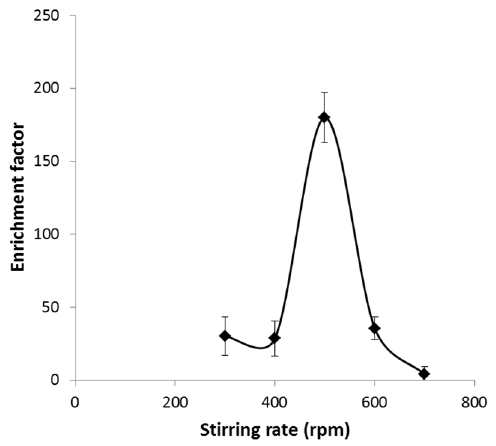
Figure 6. Effect of stirring rate on the enrichment factor. Sample pH = 5.5, DEHPA 0.9 M, HNO 3 1.9 M time of extraction 15 min, and electric potential 25 M time of extraction 15 min, and electric potential 25 V.